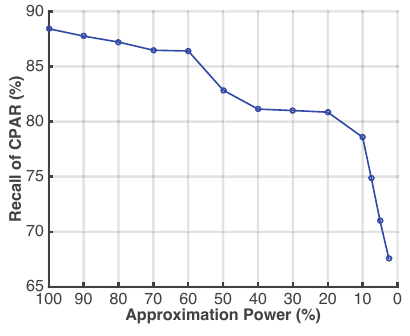
Figure 9. Accuracy (Recall) of CPAR with Different Approxima- tion Power